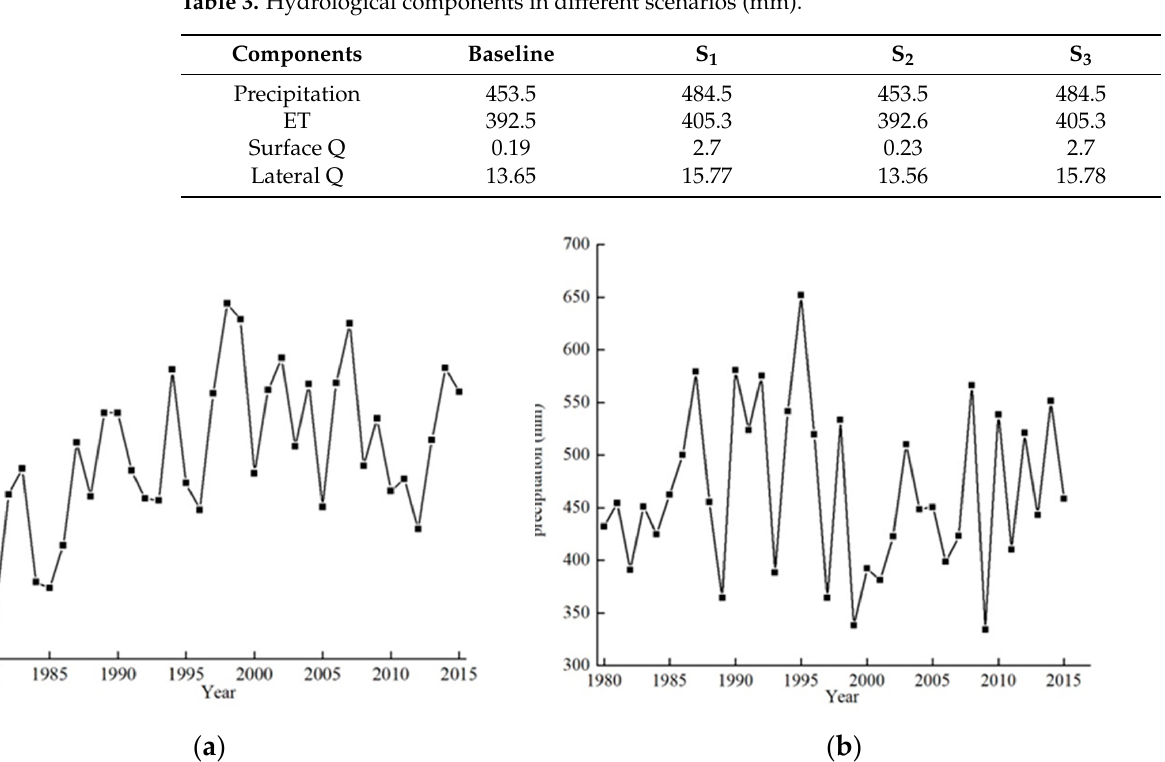
Table 4. Land use change from 1990 to 2015 (km 2